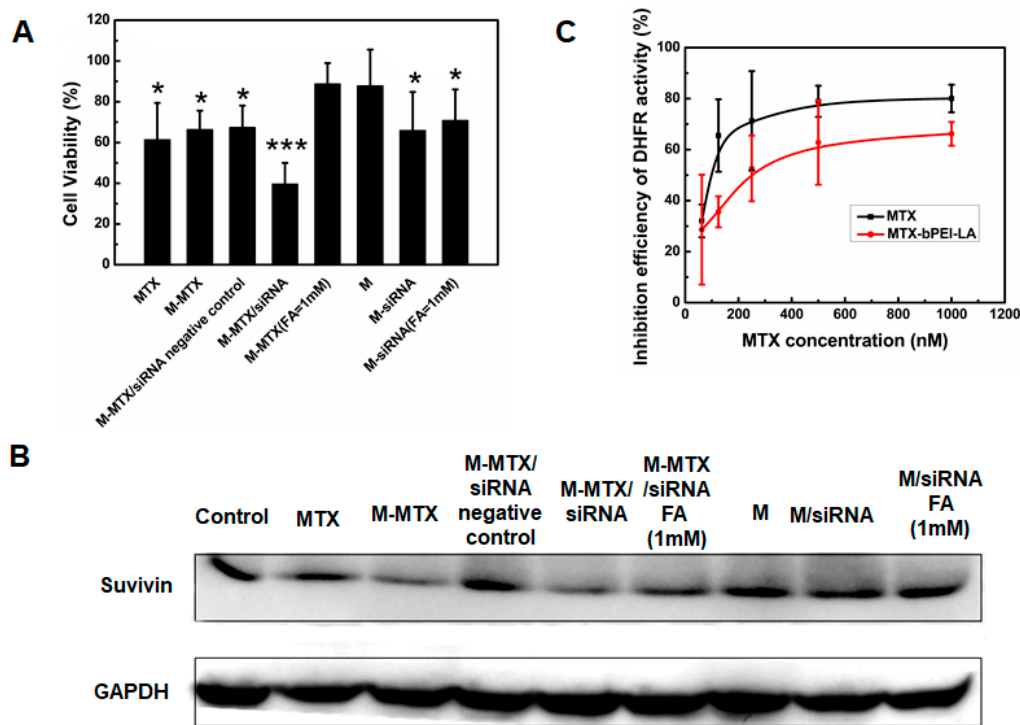
Figure 4. The cytotoxicity, protein expression, and dihydrofolate reductase (DHFR) inhibition activity of M-MTX/siRNA. ( A ) The cell viability was obtained by an MTT assay after incubation with MTX, M-MTX, M-MTX/siRNA negative control, M-MTX/siRNA, M, and M/siRNA for 48 h. * p < 0.1, *** p < 0.001. ( B ) Survivin expression was further measured by a western blot assay. The competitive inhibition was also investigated by preincubated with FA (1 mM) in advance. ( C ) The inhibition activity of MTX-bPEI-LA to DHFR was performed to evaluate the difference of inhibition activity of the conjugated MTX compared to free MTX.